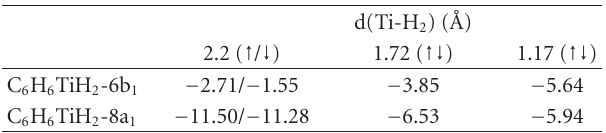
Table 1: C 6 H 6 TiH 2 MOs energies (eV). Orbital labels refer to Figure 5.